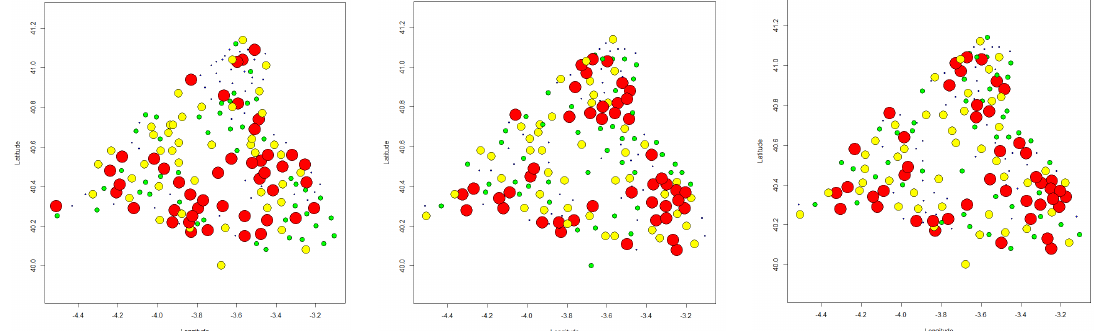
Figure 4. Left panel: Quartile map of average NO x concentrations values (2001–2009, by municipalities). Central panel: Quartile map of spatial fixed effects (SL-PD-STIRPAT, by municipalities). Right panel: Quartile map of spatial fixed effects (SD-PD-STIRPAT, by municipalities).